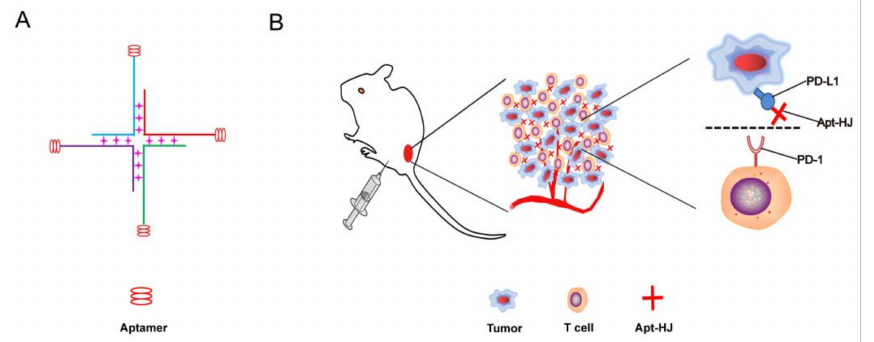
Figure 1. Schematic description of an aptamer Holliday Junction (Apt-HJ) designed for colon cancer treatment. ( A ) The structure of Apt-HJ, which was made of four ssDNA chains. Each ssDNA had a PD-L1 aptamer at the 3 (cid:48) end and the sequence for HJ at the 5 (cid:48) end. ( B ) Schematic illustration of Apt-HJ’s binding to PD-L1 on the surface of tumor cells for blockade of PD-L1/PD-1 interaction.